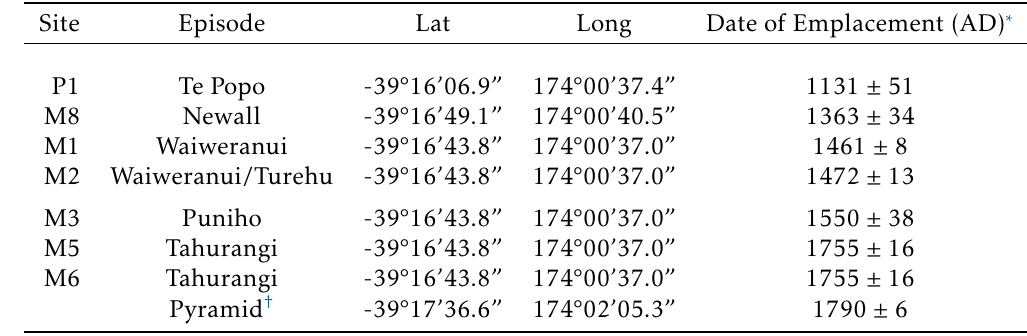
Table 1 – Site locations and Unit Dates of Emplacement.